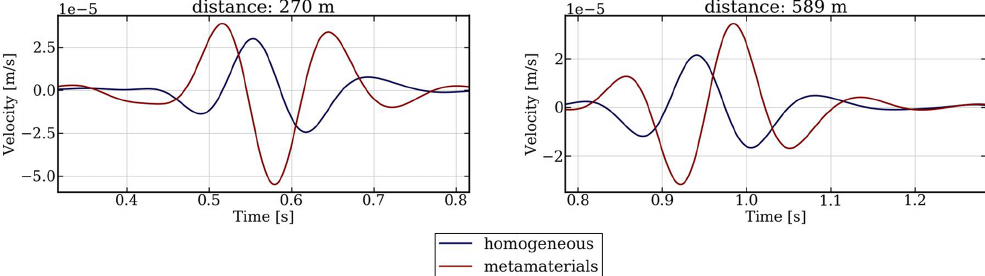
Figure 2. Simulation results for the cross-shaped cavities (red line) in comparison with models without cavities (homogeneous model, blue line). The distance of the seismic station is indicated on top of each